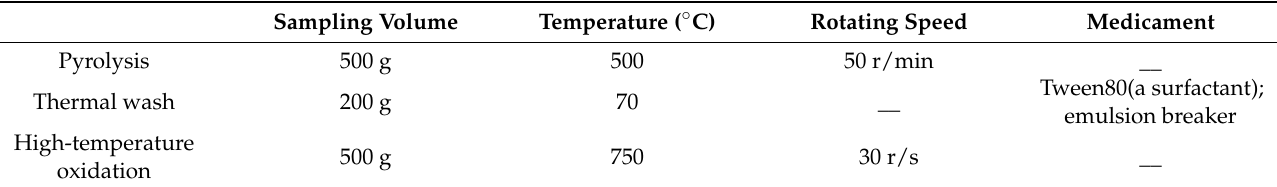
Table 1. Preparation conditions for residues prepared by different heat treatment methods.